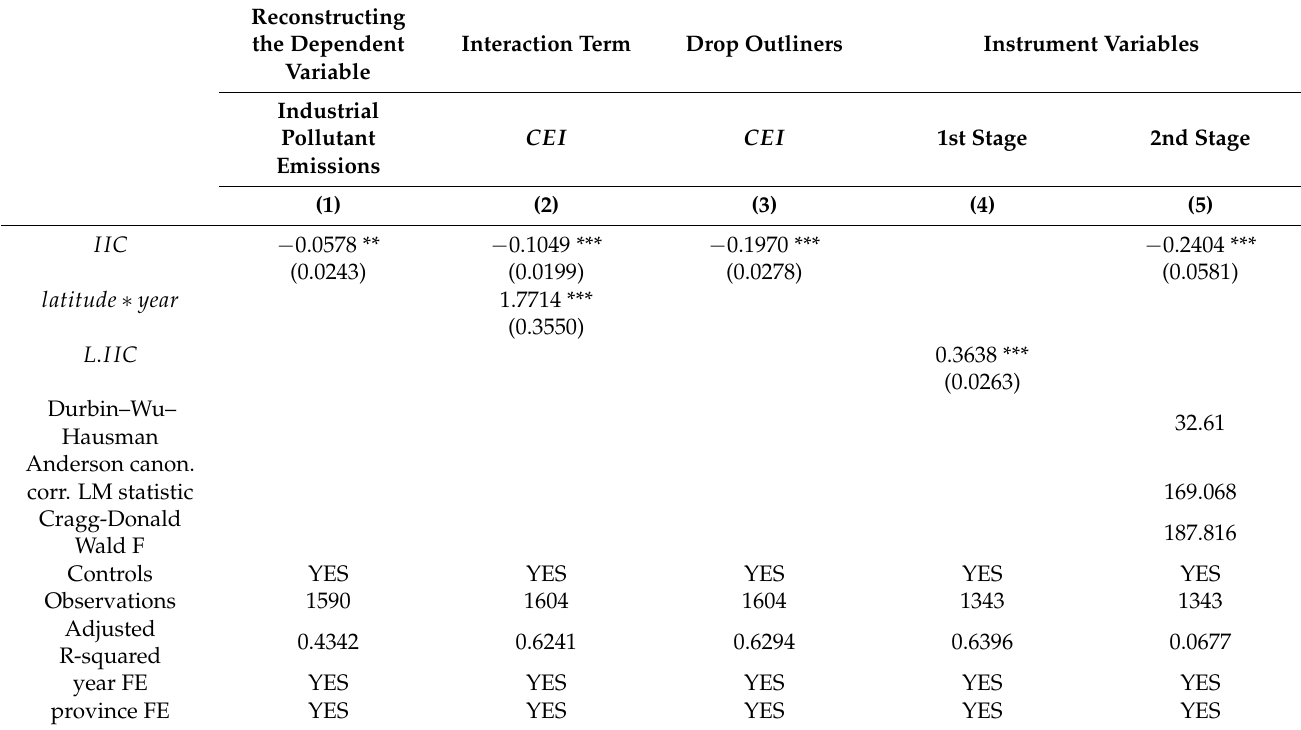
Table 6. Robustness